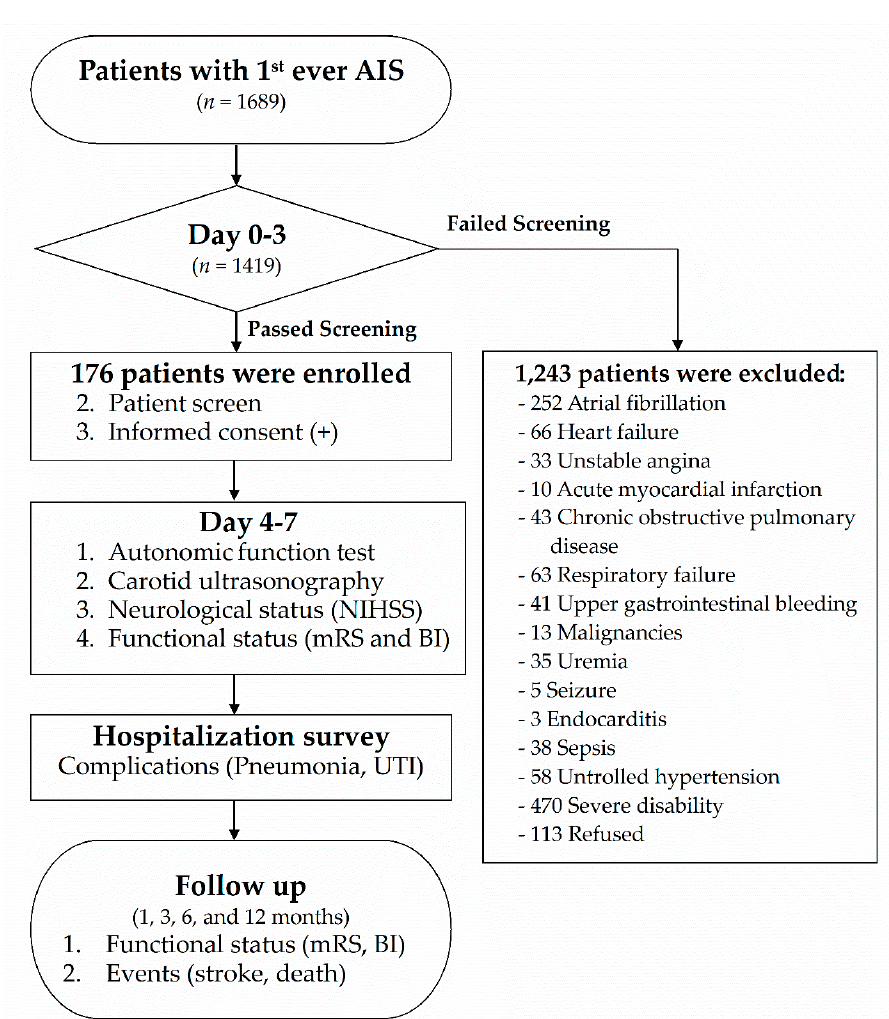
Figure 1. Flow chart of the study. AIS: acute ischemic stroke; UTI: urinary tract infection; BI: Barthel Index; NIHSS: National Institutes of Health Stroke Scale; mRS: modified Rankin scale.